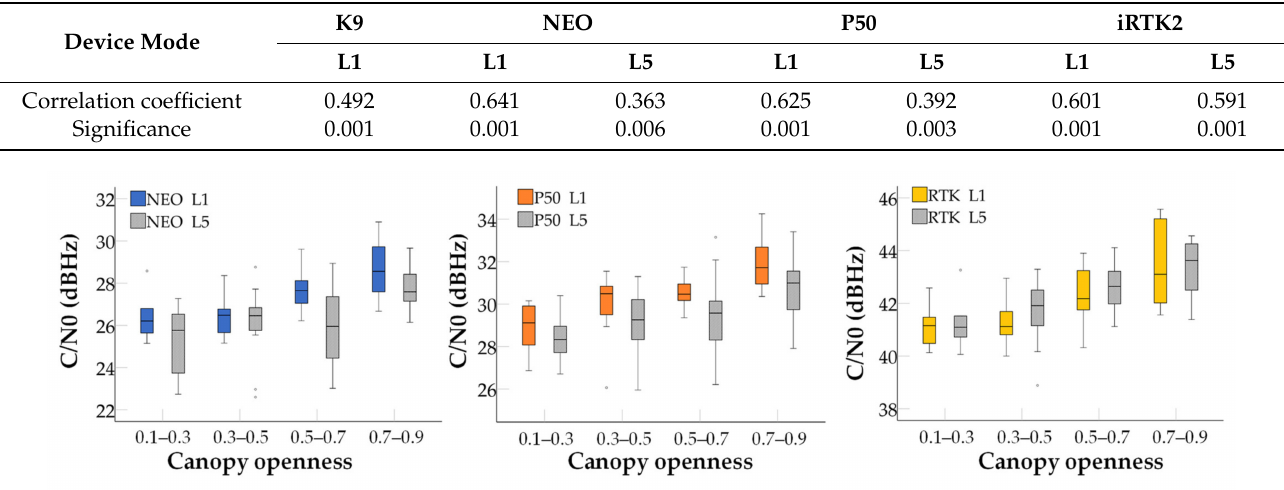
Figure 9. Comparison of C/N0 of NEO, P50, and iRTK2 in L1 and L5